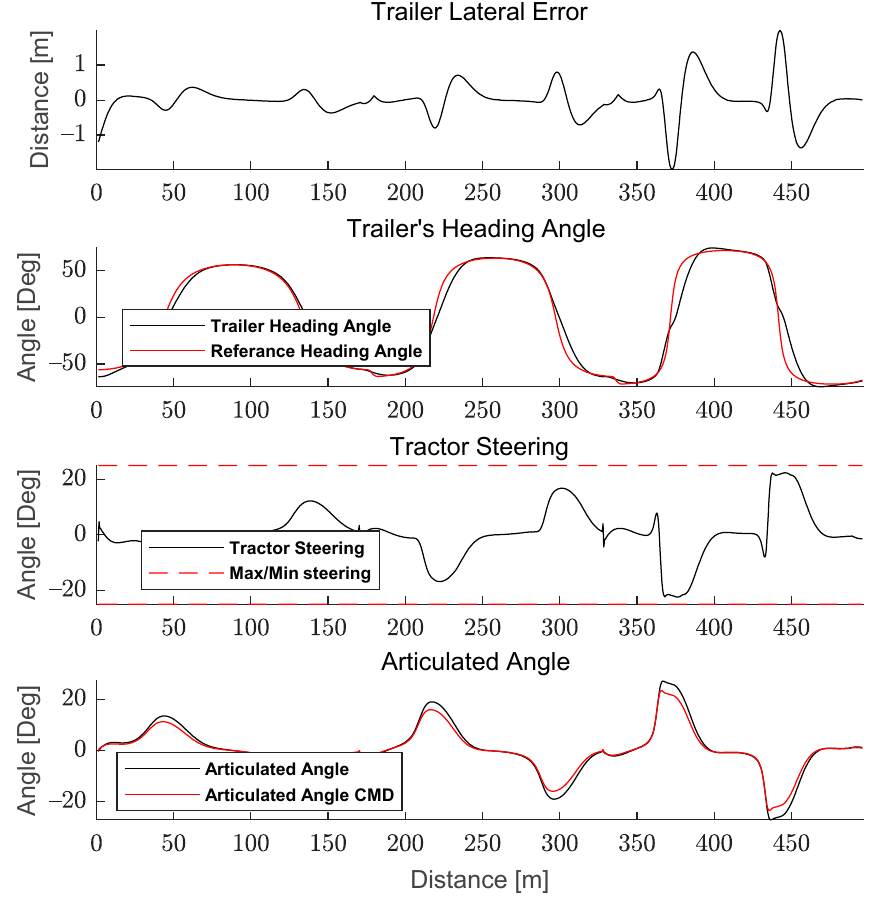
Figure 5. Trailer lateral error, Trailer’s heading angle with respect to Reference heading angle, steering commands, and the articulated angle.